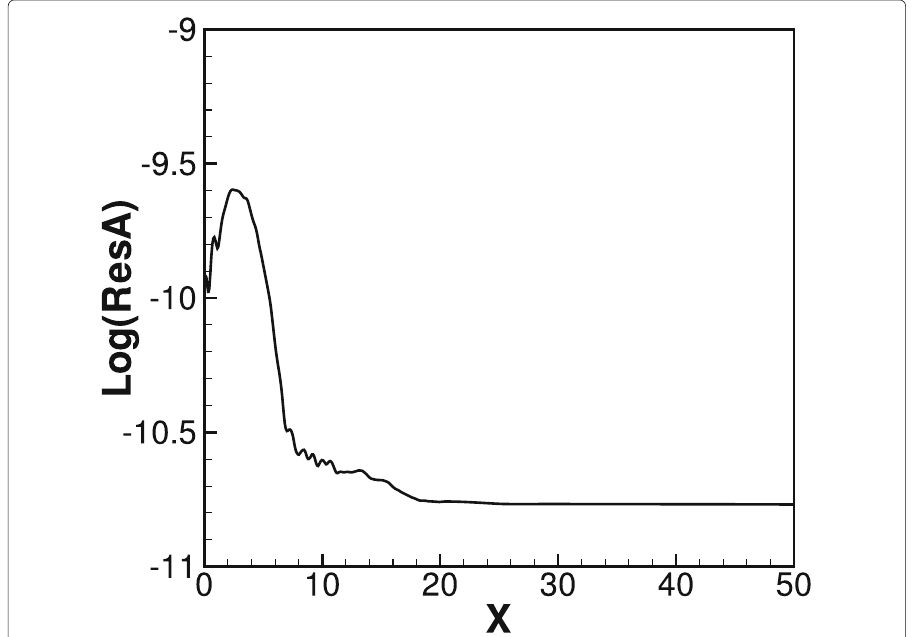
Fig. 4 The time evolution of the average residue of a two-dimensional isentropic